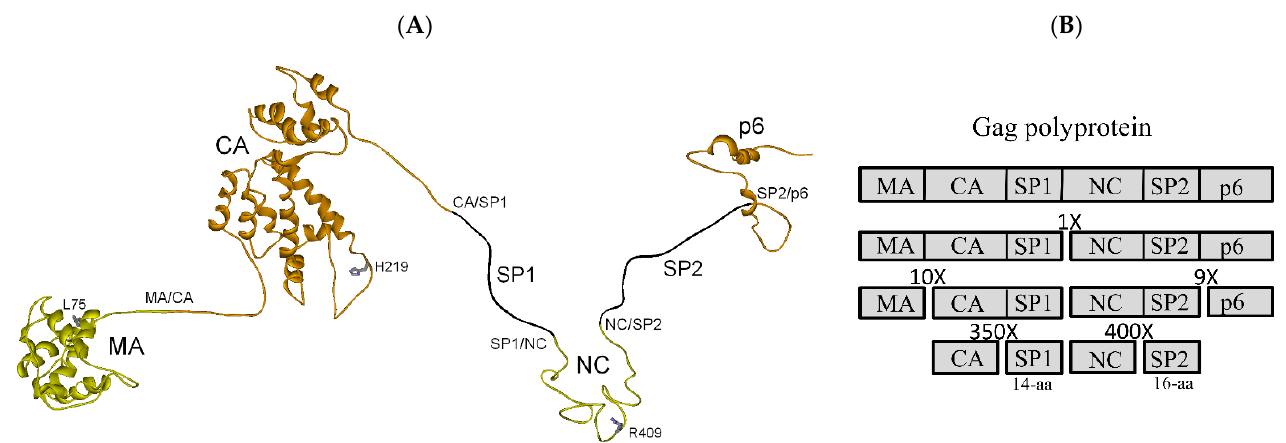
Figure 2. ( A ) Structure-based model of HIV-1 full-length Gag polyprotein as previously reported [22], ribbon backbone with subdomains indicated left-to-right (MA yellow 1L6N.pdb, CA bronze 1L6N.pdb and 4XFX.pdb, NC yellow 1MFS.pdb, p6 bronze 2C55.pdb as modified [22]), SP1 and SP2 regions in black, five Gag cleavage sites indicated as are the non-cleavage site residues MA L75, CA H219, and NC R409, which when mutated resulted in PI resistance (carbon grey, nitrogen blue) [30]. ( B ) Schematic diagram of HIV-1 Gag polyprotein with PR cleavage sites and products indicated, inverse relative cleavage rates for the five sites indicated with the SP1/NC cleavage site set to 1 and the NC/SP2 cleavage site 400X slower, as reported by Pettit and coworkers [31,32]. Length of the cleaved SP1 and SP2 peptides indicated.